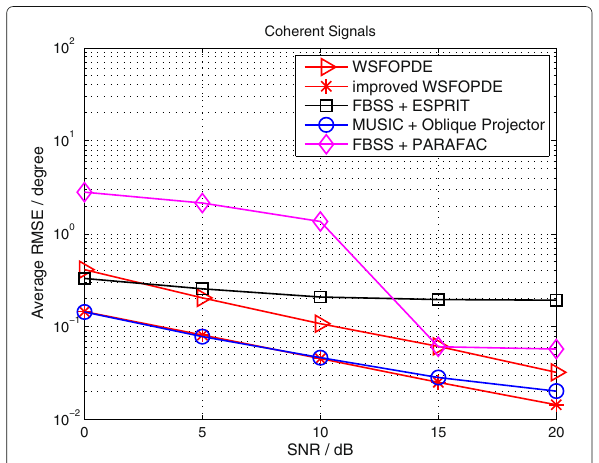
Fig. 2 The performance comparison of DOA-DOD